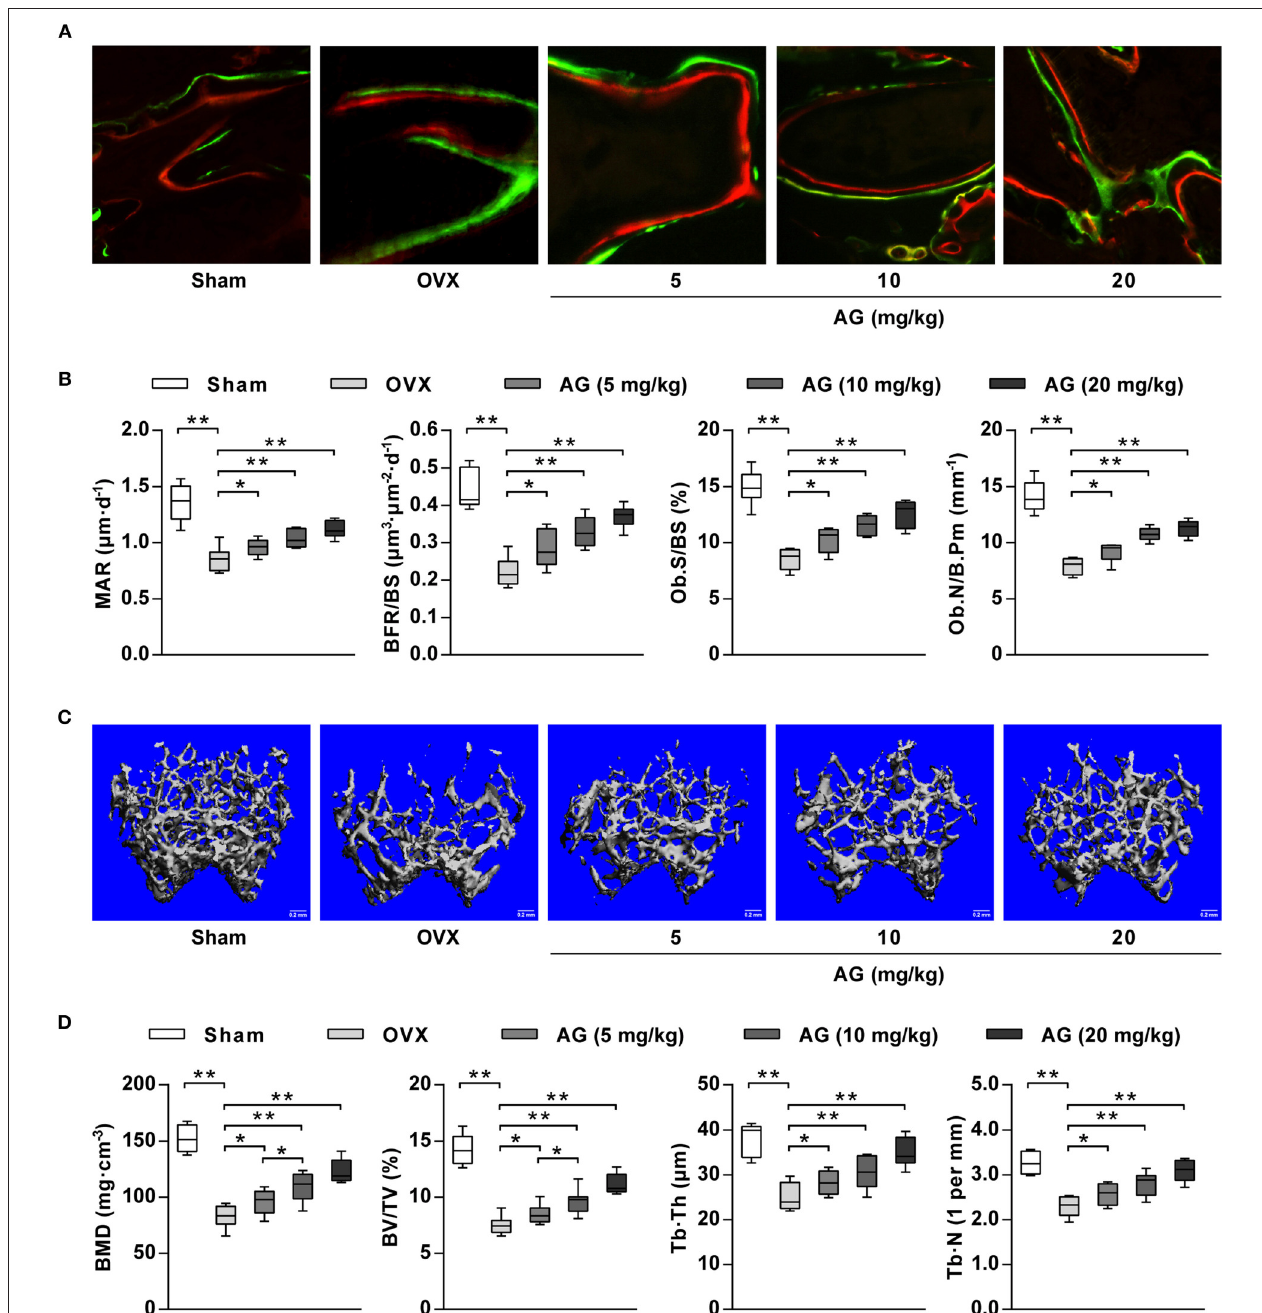
FIGURE 5 | The effect of AG on bone formation in vivo . OVX mice were treated with different doses of AG for 4 weeks. (A) Representative images of bone formation at the distal femur examined using double staining with xylenol orange and calcein green in AG-treated mice and OVX mice. (B) The values of MAR, BFR/BS, Ob.S/BS, and Ob.N/B.Pm at the isolated distal femur from AG-treated mice and OVX mice determined using bone histomorphometry analysis. (C) Representative images of the distal femur metaphysis in AG-treated mice and OVX mice reconstructed using micro-CT. Scar bars, 0.2mm. (D) The values of BMD, BV/TV, Tb.Th., and Tb.N. at the distal femur metaphysis in AG-treated mice and OVX mice using micro-CT. * P < 0.05, ** P < 0.01 compared with the corresponding control group. N = 8 for each group. and biomaterials in bones (41, 42). After treatment with AG For our in vivo study, OVX-induced osteoporosis in mice was selected as a bone repair model because it has been widely for 4 weeks, bone histomorphometric analysis and micro- used to evaluate the bone formation of bioactive molecules CT analysis were used to measure the effect of AG